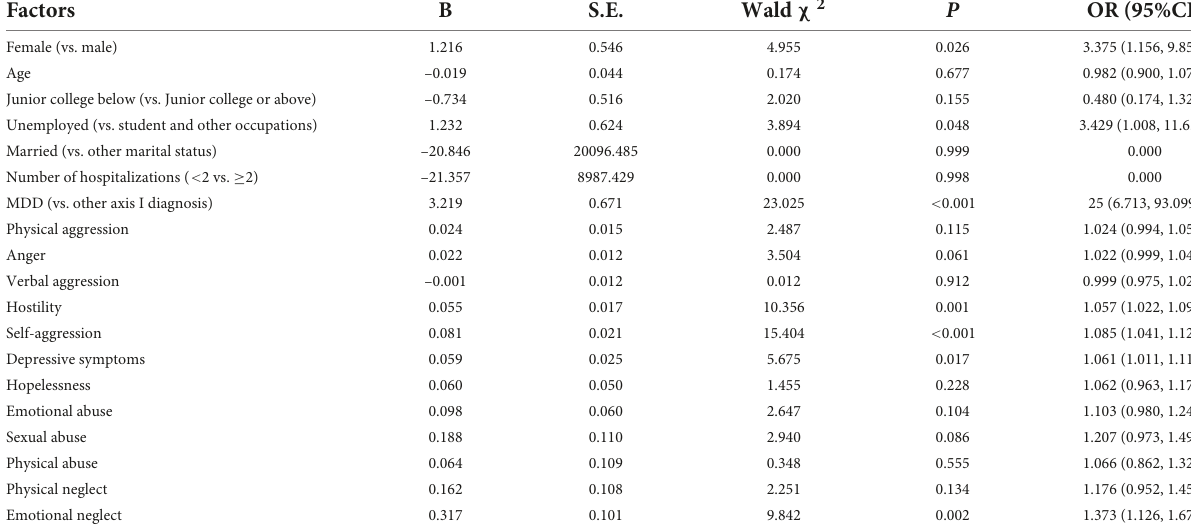
(OR = 26.773, CI = 3.914–183.132, P = 0.001), hostility